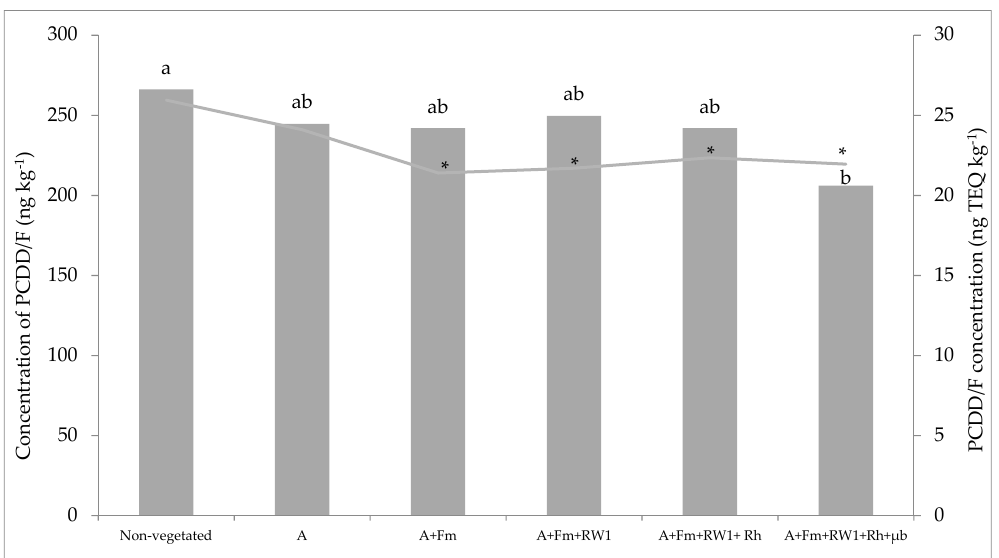
Figure 2. Residual polychlorinated dibenzo-p-dioxins/furans (PCDD/F) concentrations in the polluted soil after six months of culture in ng.kg − 1 (histogram) and ng TEQ kg − 1 (curve) for the different conditions. Conditions consisted of non-vegetated soil, non-inoculated alfalfa (A), combined with F. mosseae (A+Fm), plus S. wittichii RW1 (A+Fm+RW1), plus rhamnolipids Rh (A+Fm+RW1+Rh), plus microbiota µb (A+Fm+RW1+Rh+µb) grown in microcosms for six months. Different letters indicate significant differences between conditions according to the Kruskal–Wallis test ( p ≤ 0.05). (*) indicate significant differences between conditions compared to the control non-vegetated soil. Values are means ± s.d. ( n = 3).